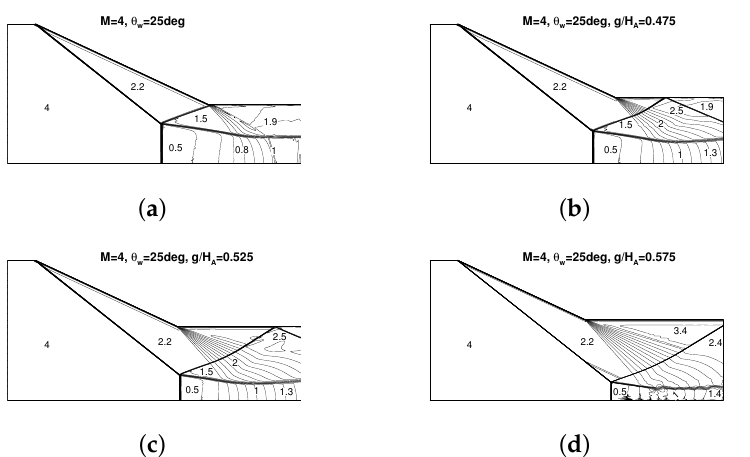
= 0.425; ( b ) g H A H A